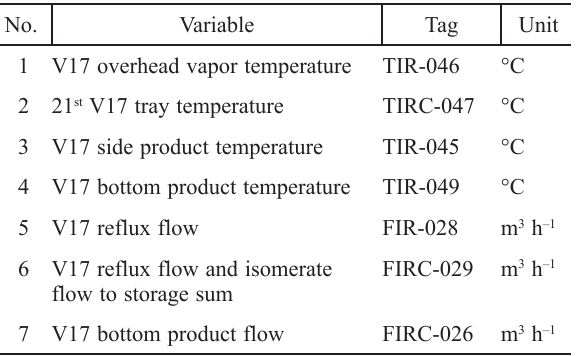
Table 6 – Input variables for the development of 2,3-DMB content SVM model No.